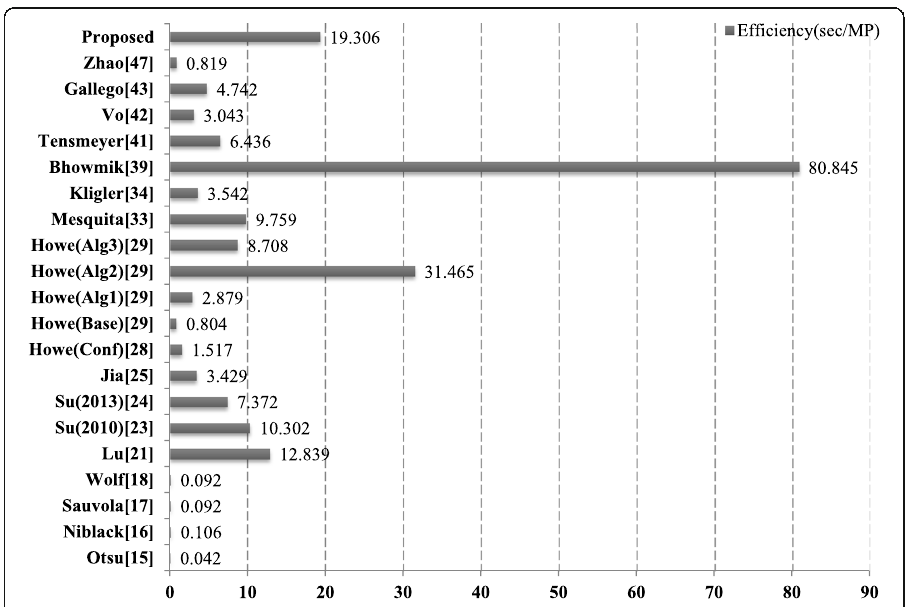
Fig. 9 Average running time (sec/MP) of each binarization